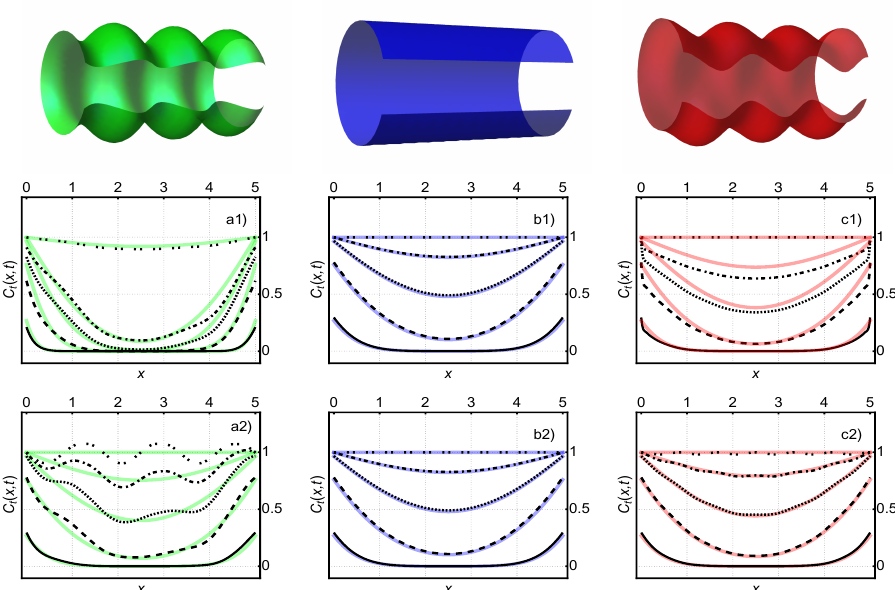
Figure 8. Concentration profiles in three pores depicted above, where an homogeneous adsorption process takes place along the pore with equal concentrations at both ends. In ( a1 ) we show the predictions of the concentration profiles for a tortuous pore (green) when adsorption and bulk diffusion takes place at different times. Black lines show the predictions by Equations (16) and (29) whereas solid color lines (green) show the prediction by the most elemental one-dimensional diffusion Equation (12) having no-corrections from the geometry of the pore. In ( a2 ) we show a similar comparison in the presence of surface diffusion. The comparisons in ( b1 , b2 ) correspond to the cylindrical pore (blue) and show that, only in this case, the approaches are equivalent, as expected. Comparisons in ( c1 , c2 ) correspond to the winding pore (red). Remarkable differences between tortuous and winding pores emerge from this simulation study, in particular in the case when surface diffusion is present. Cylindrical and tortuous pores have very similar behavior whereas the tortuous pore introduces large deviations with respecto to the elemental description of the concentration profile. See Appendix A for details of the parameters used in the